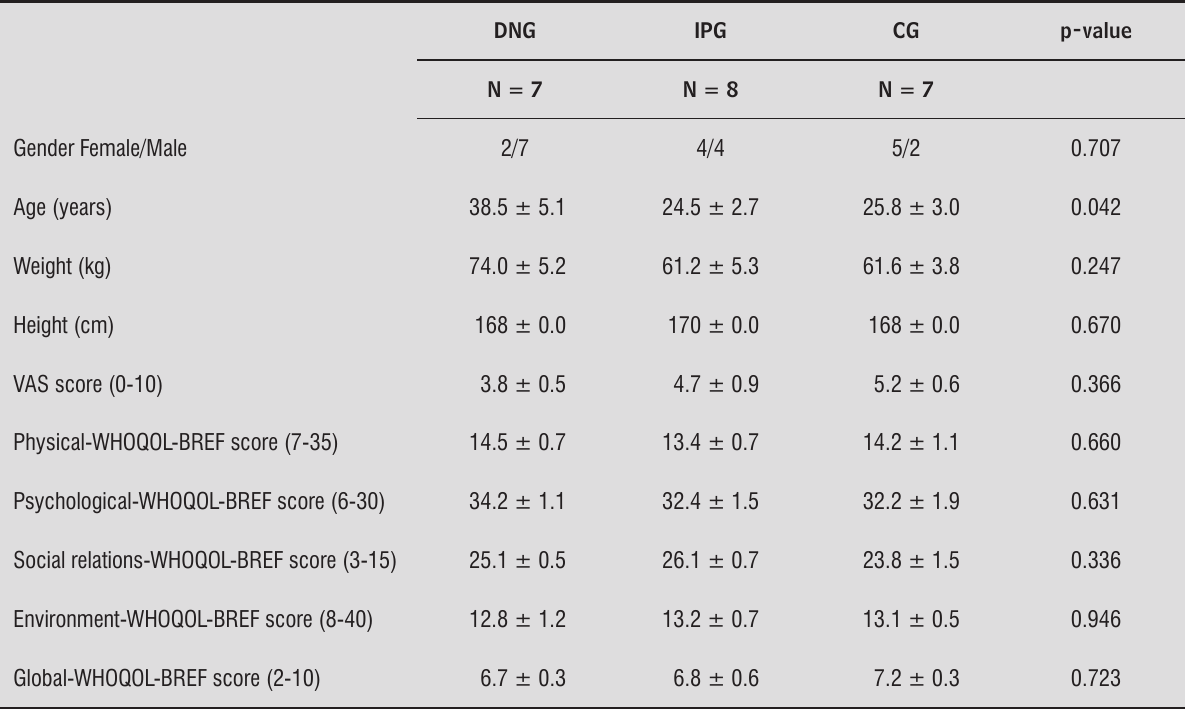
Table 1 - Comparison of patient’s characteristics and baseline